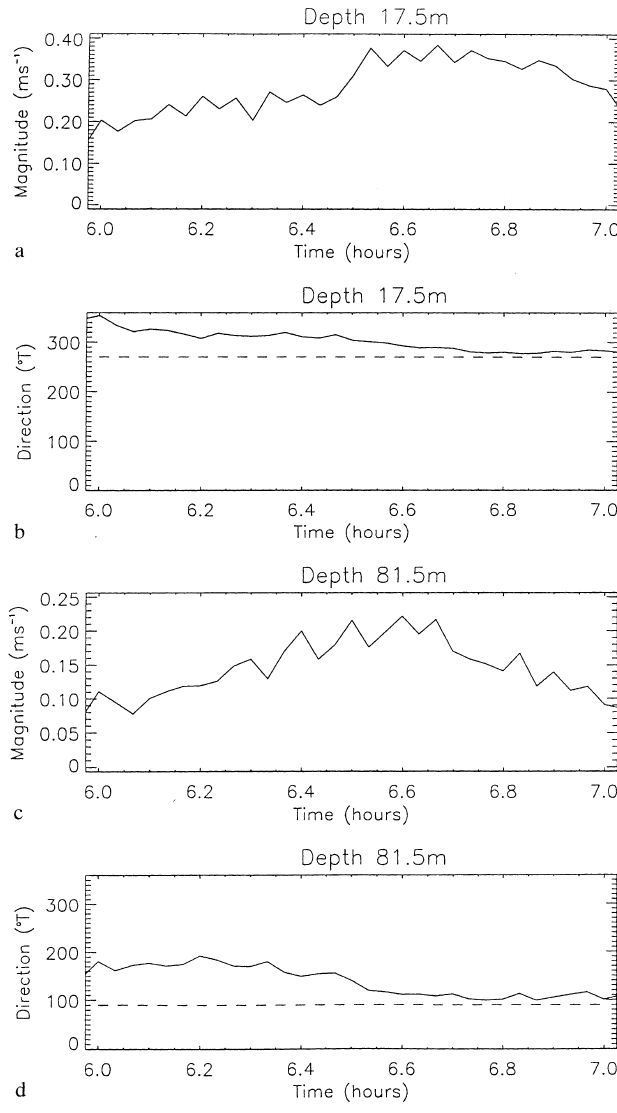
Fig. 9a–d. Magnitude and direction of the internal currents at a , b 17.5 m depth and c , d 81.5 m depth from ADCP, between 0600 and 0700 h, 13 August, 1996. Overplotted on the direction plots is the b 270 (cid:176) T and d 090 (cid:176) T angles indicating the cross-slope (and survey